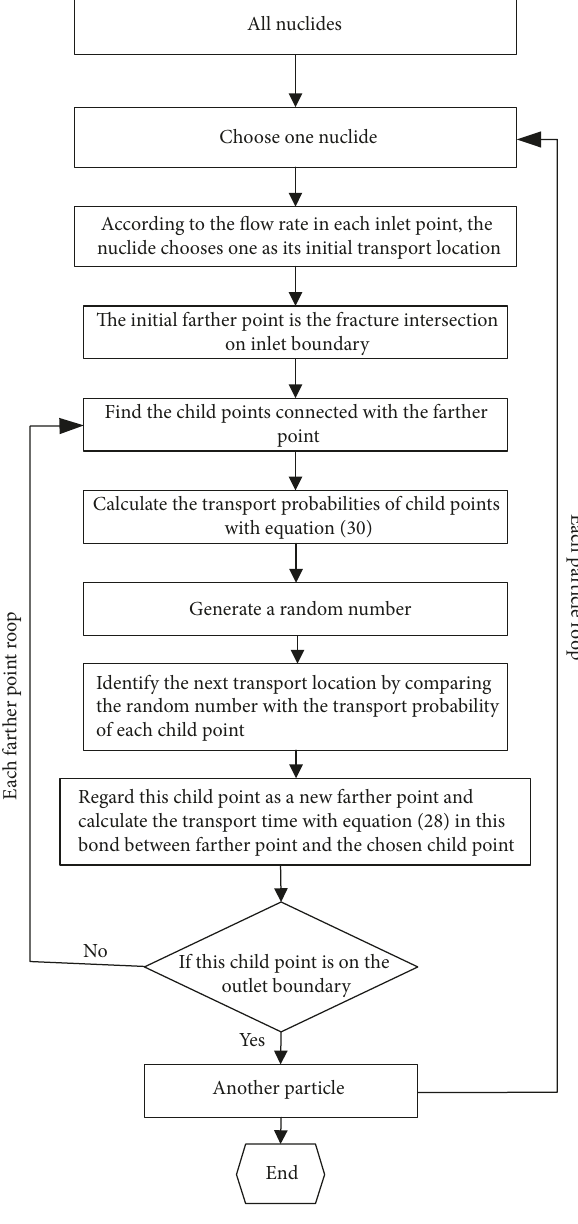
Figure 4: Flow chart of TDRW method’s